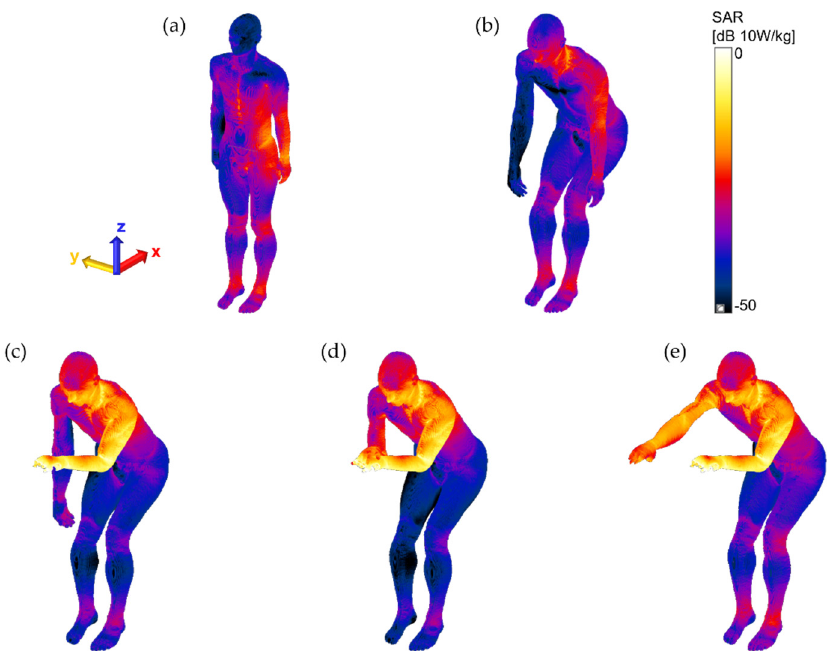
Figure 4. Surface SAR of each pose of patient assistant for visual observation of the distribution of SAR for each pose in decibel scale (relative scale to 10 W/kg).